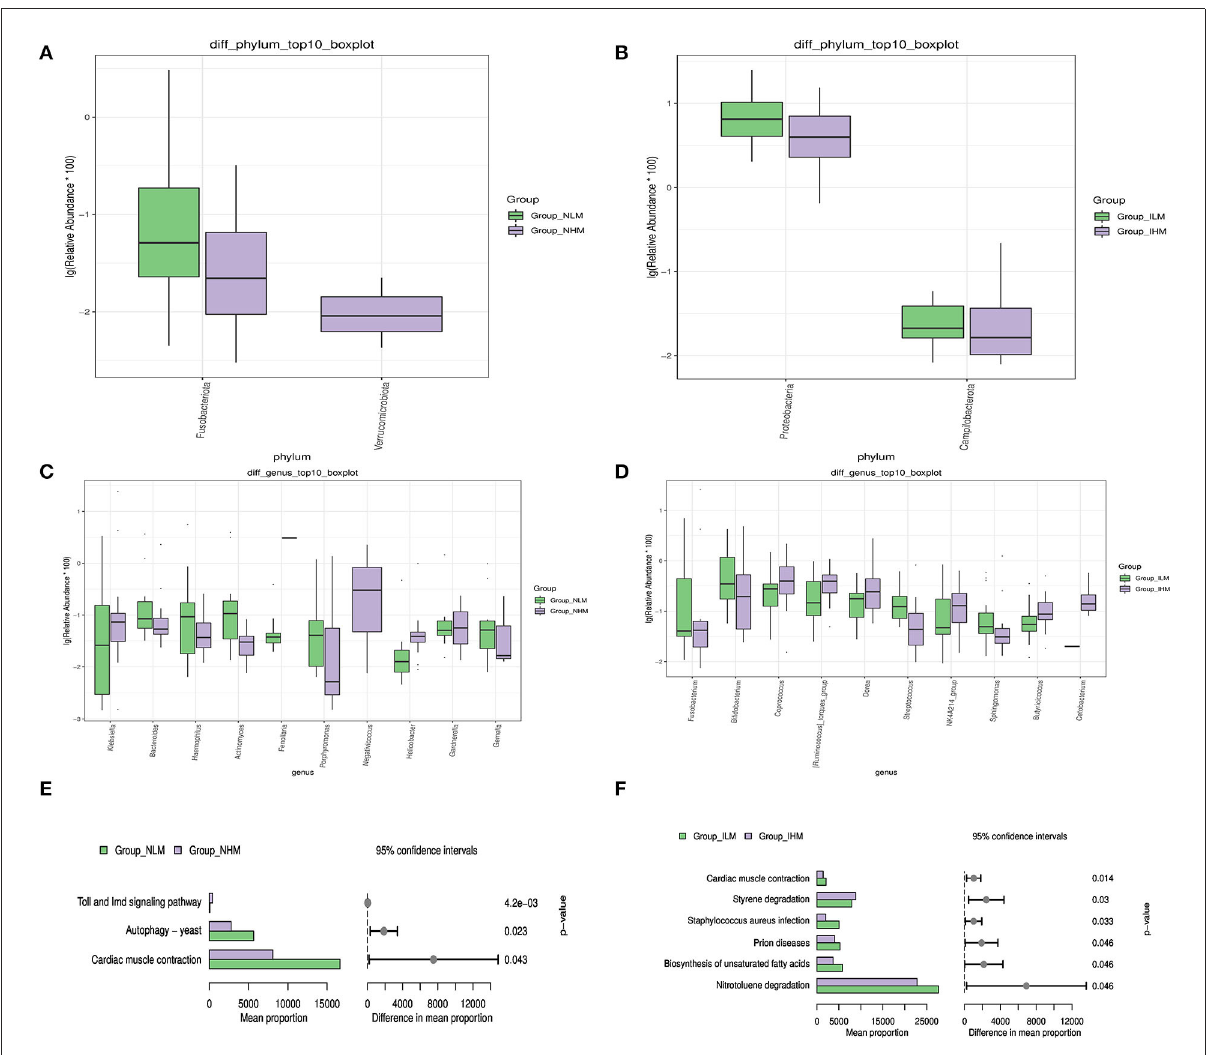
FIGURE4 Microbiological multivariate statistical analysis. (A–D) The Wilcoxon analysis. (E,F) Prediction of gene function of known